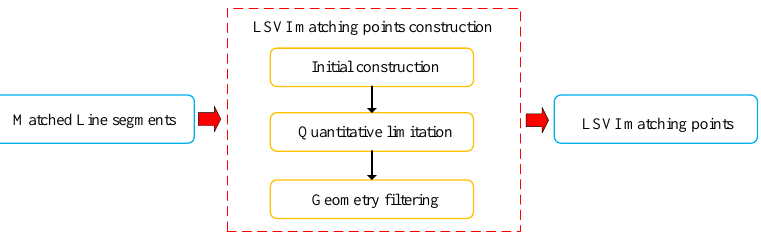
Figure 8. A flowchart of constructing LSVI matching points. The input of the algorithm module is the matched line segments, and the output is the LSVI matching